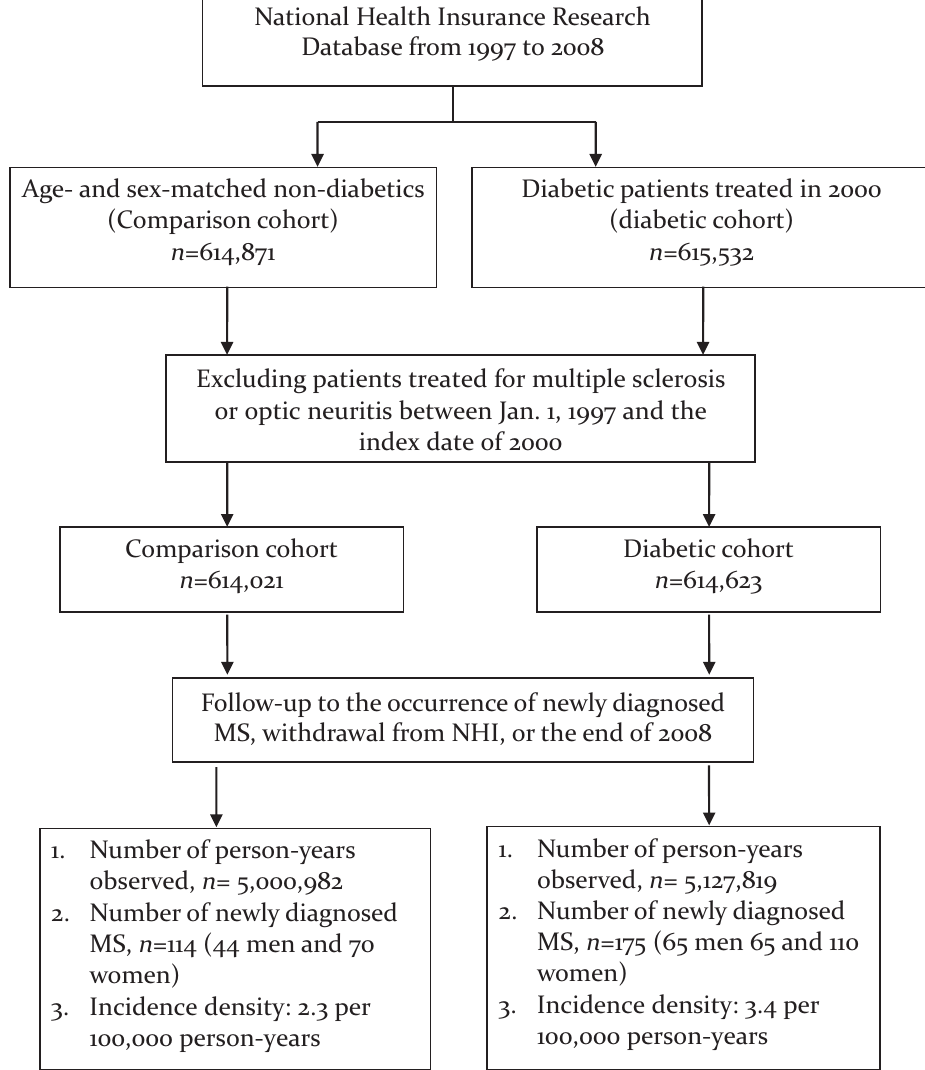
Fig. 1. Flowchart for the study cohort enrollment and follow-up. MS, multiple sclerosis; NHI, National Health Insurance.